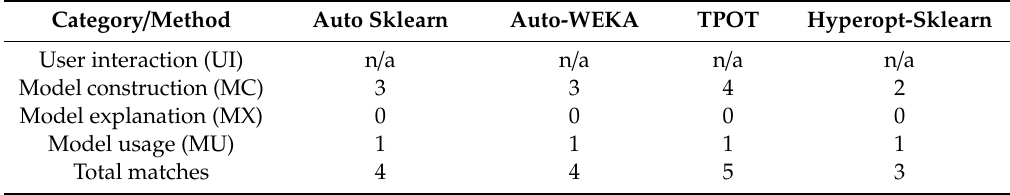
Table 3. AutoML method scores on user story